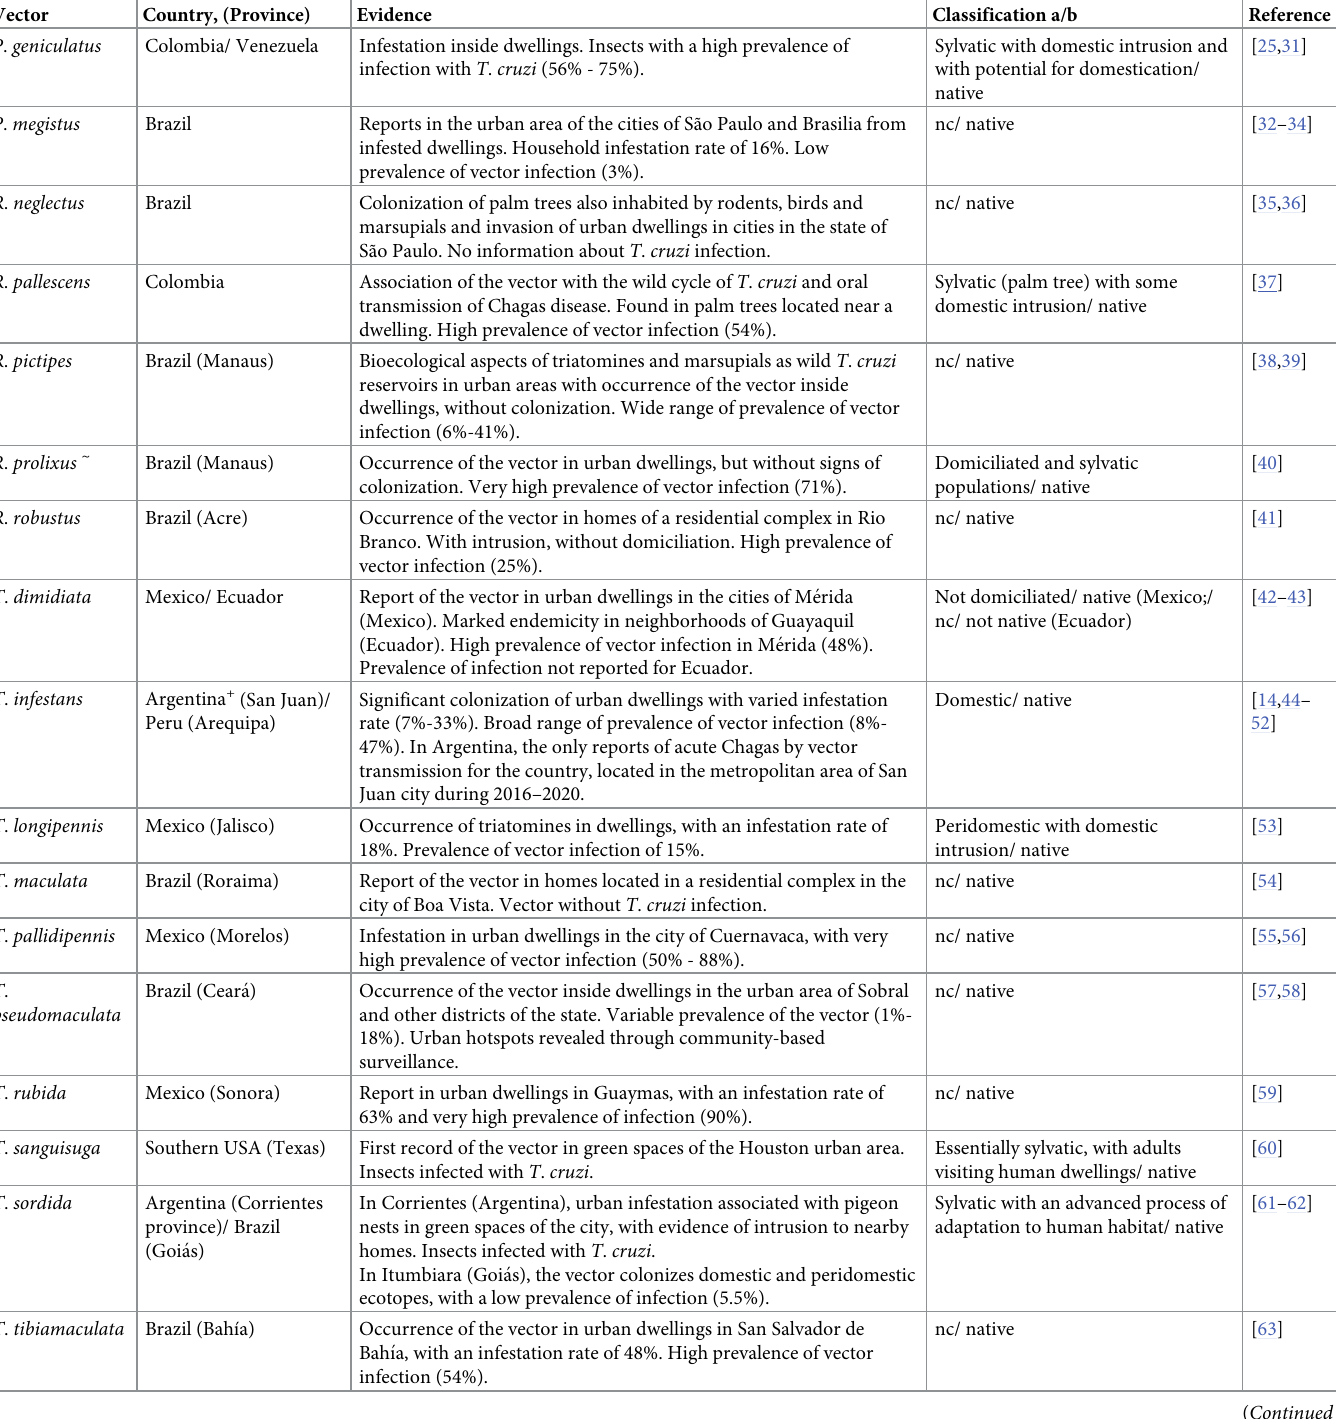
Table 1. Chagas disease vector occurrence in urban contexts: main triatomine species reported with greater abundance in the revised documents, intradomiciliary infestation and bug infection with Trypanosoma cruzi .